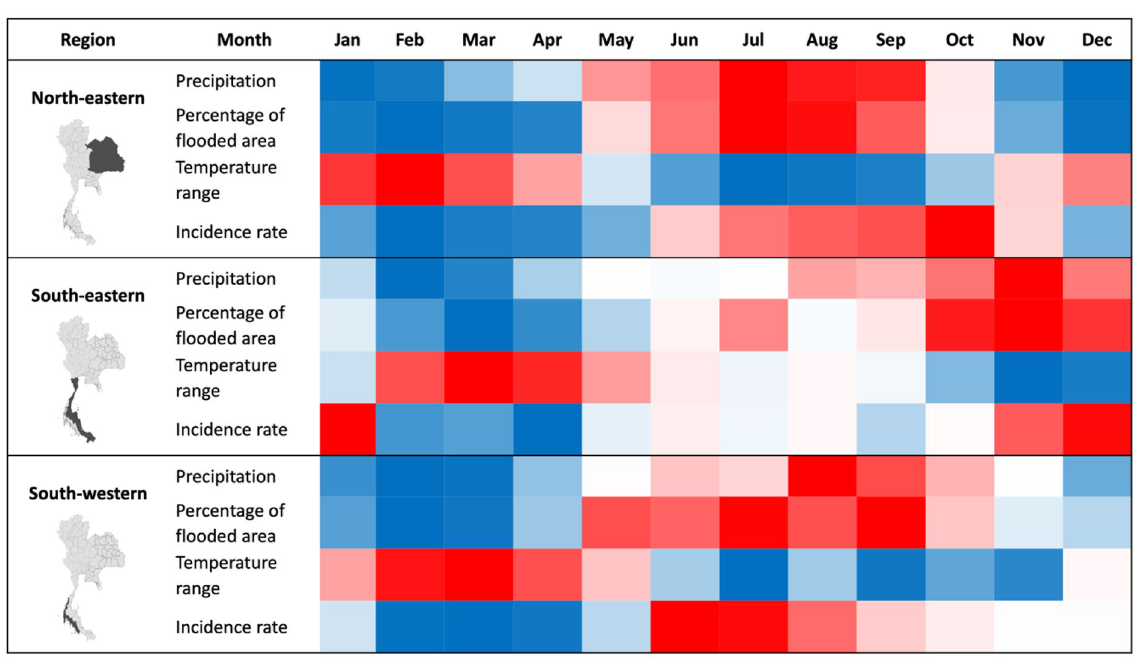
Figure 4. Heatmaps of monthly precipitation, monthly percentage of flooded area, monthly temperature range, and average of incidence rate for 3 regions. Red highlights the high values. Blue highlights the low value. The 3 regions were mapped in dark grey. The heat map created using Microsoft Excel version 16.57 (https:// www. micro soft. com/ th- th/ micro soft- 365/ excel). Maps created using R Program version 4.0.3 (https:// www.r- proje ct.